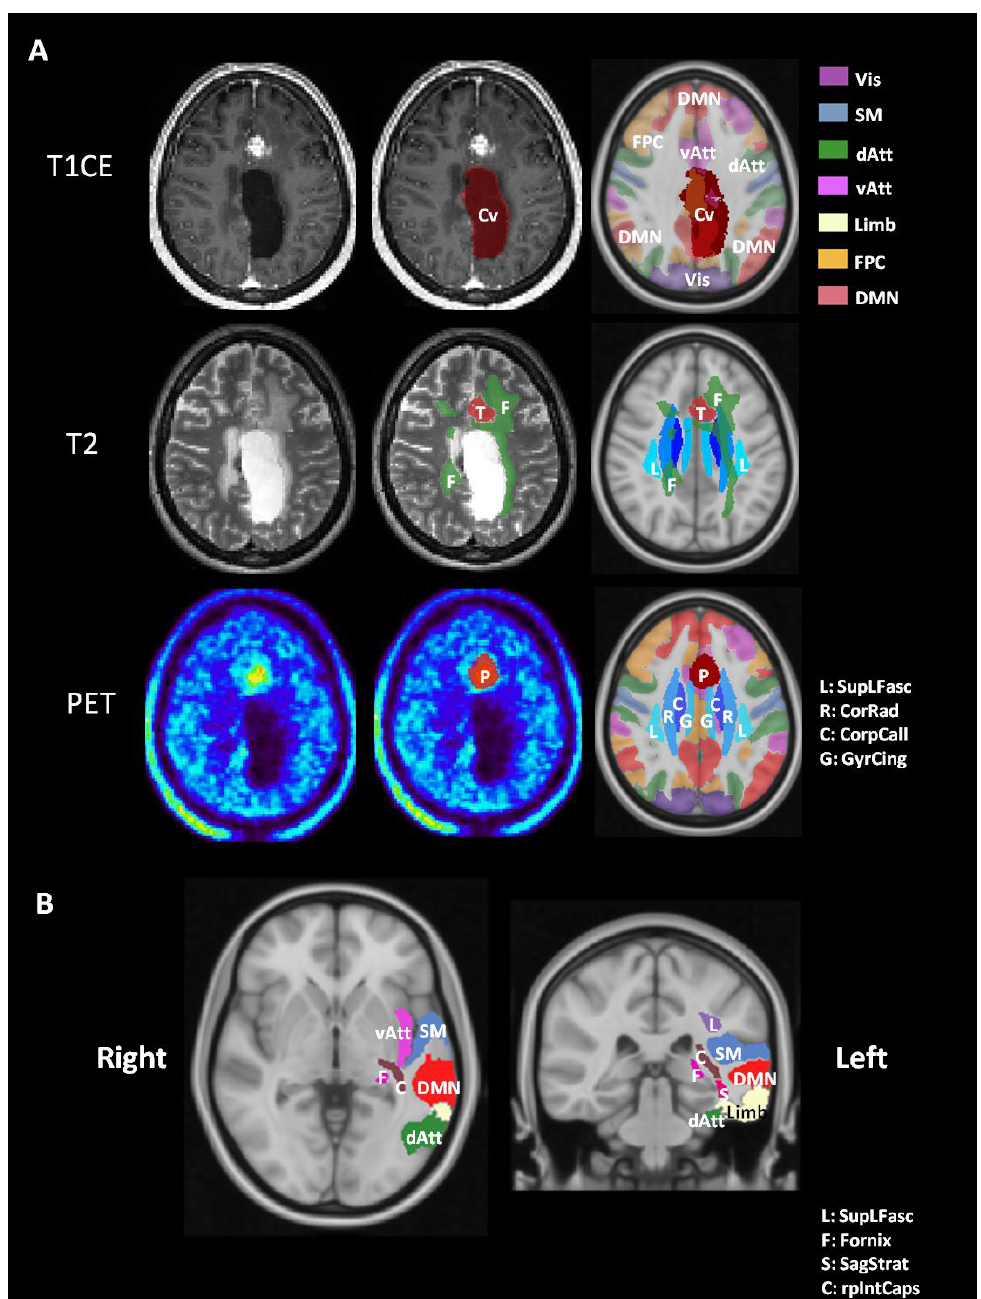
Figure 1. ( A ): Image processing and analysis. Contrast enhancing tumors (T), T2/FLAIR hyperintensities (F), and FET-PET positive tumors (P) were segmented semi-automatically; resection cavities (Cv) were manually outlined. After elastic